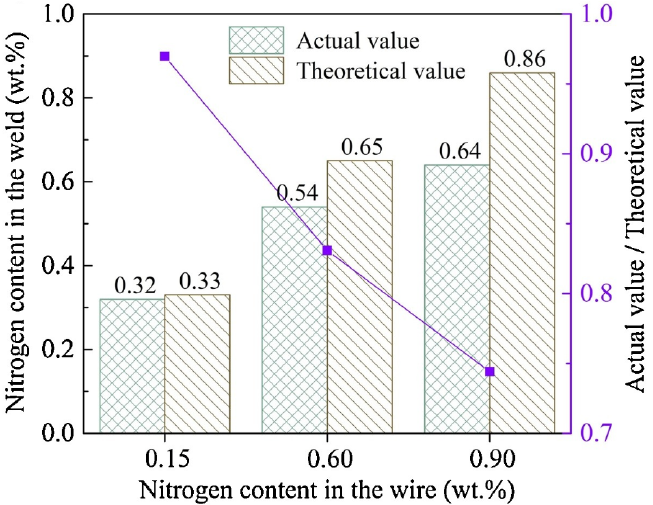
Figure 8. Effects of different weld wire nitrogen content on weld nitrogen content. Reprinted with permission from ref. [27]. Copyright 2021, Elsevier.